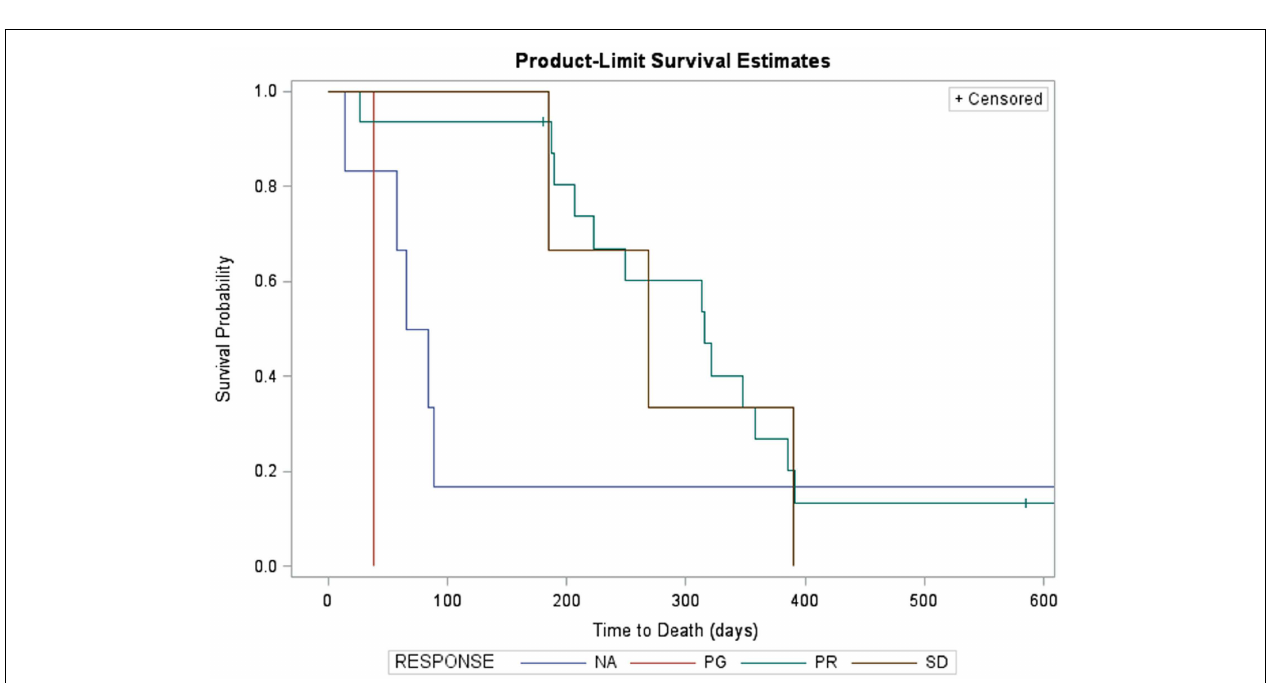
survival data. Significant differences in survival were found (log-rank χ 2 = 25.3, p < 0.0001). Partial responders survived, on average, 321days (95% CI: 189, 385). Subject with progressive disease survived 38days. Subjects not evaluated for response had median survival of 65days (95% CI: 14,